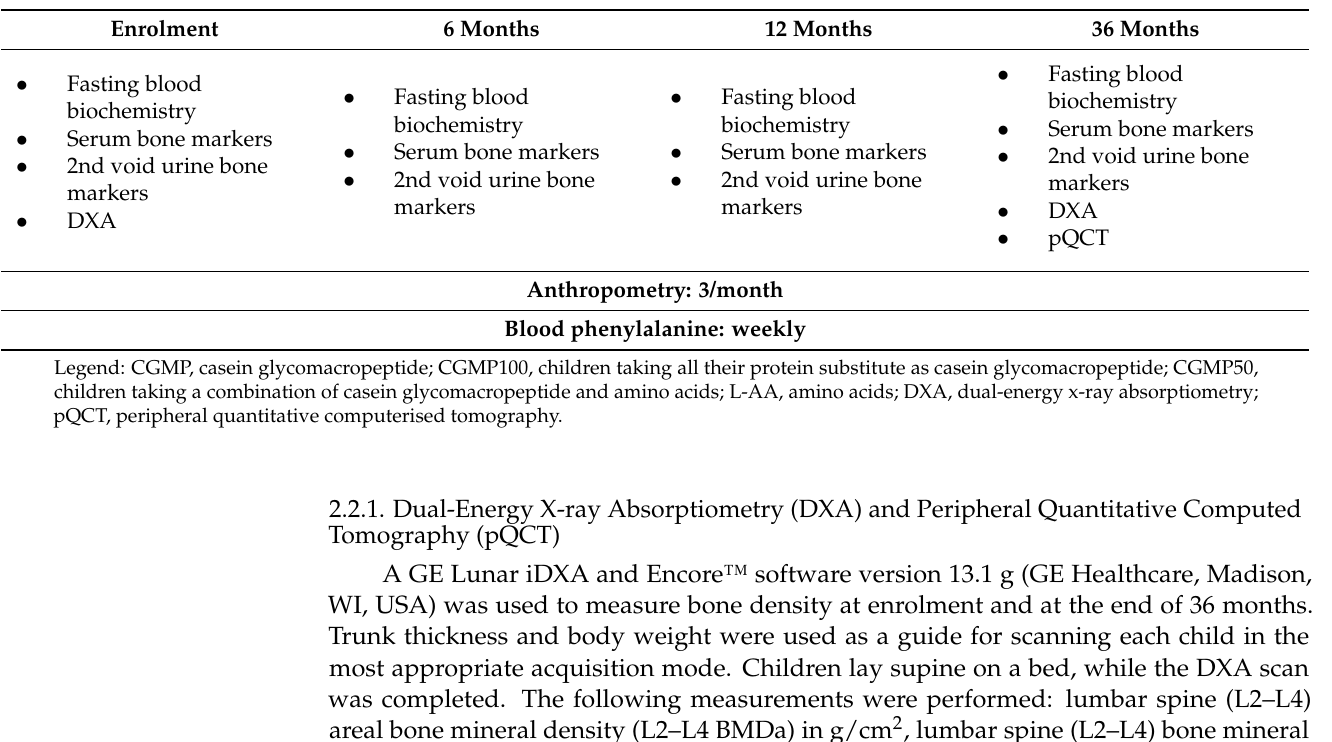
Table 1. Frequency of nutritional blood biochemistry, bone blood and urine markers, DXA and pQCT scans, over study duration from enrolment to 36